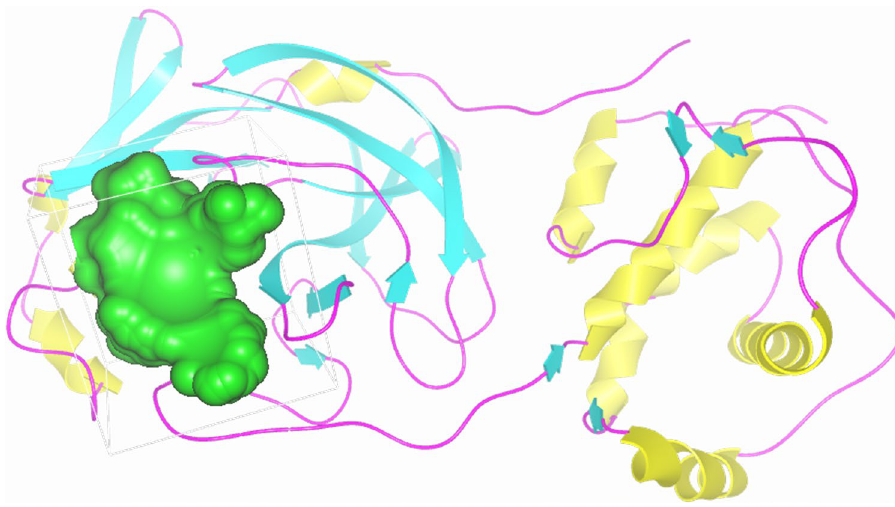
Figure 1. 3CLpro secondary structures and potential binding pocket for C 60 fullerene